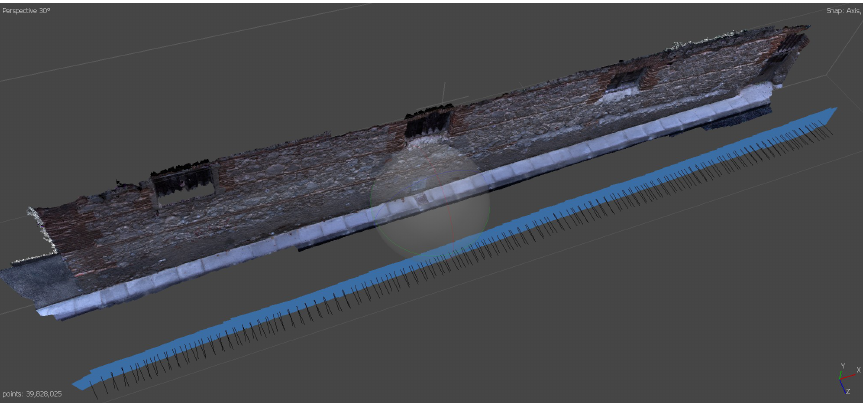
Figure 13. Distribution of the shots taken during visible spectrum capture process (upper view).